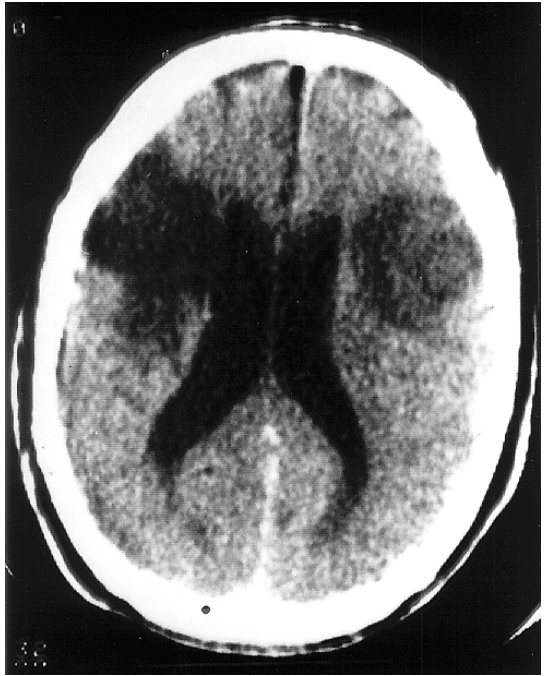
Fig. 4. CT scan, Patient 4. The scan shows bilateral cortical- subcortical infarctions involving the operculum, larger right than